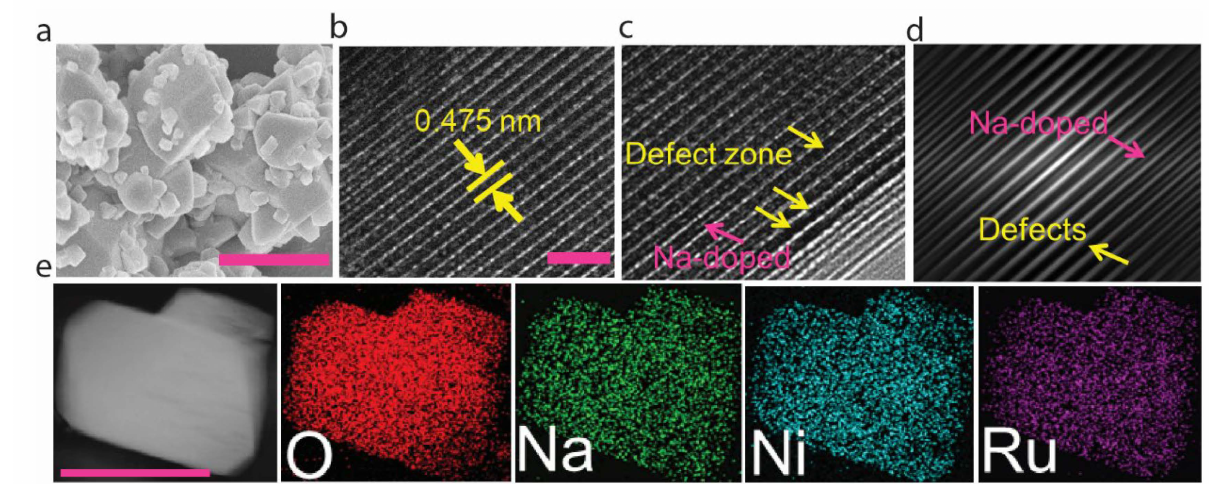
Figure 2. Morphological and structural characterizations. ( a ) SEM image of 2 showing several small particles decorating larger particles (scale bar 2 µ m). ( b ) Representative HRTEM image showing lattice fringe distance 0.475 nm corresponding to (002). (scale bar 2 nm). ( c ) HRTEM image showing defective zones (marked with yellow color) and the lattice Na-doped (marked with pink color). ( d ) the autocorrelated image corresponding to c. ( e ) High-angle annular dark-field scanning transmission electron microscopy (HAADF-STEM) and EDS elemental mapping showing the uniform distribution of elements with a slightly increased concentration of elemental oxygen on the surface of 2 (scale bar 250